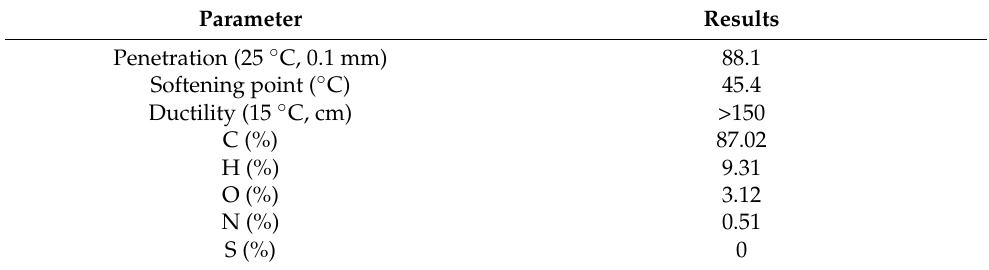
Table 1. Basic technical indexes of 90#A.